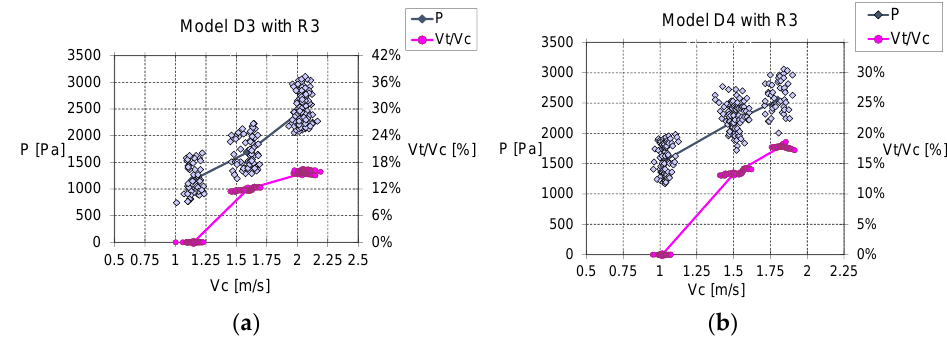
Figure 21. Characteristics 𝑃 and 𝑉 𝑡 /𝑉 𝑐 with resistance R3, for models D3 ( a ) and D4 ( b ).